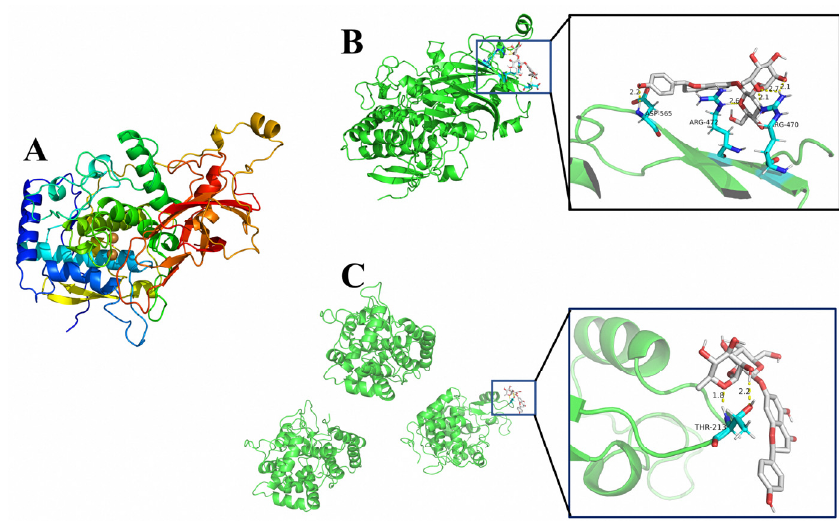
Figure 5. The 3D structure and molecular docking results. ( A ). The 3D crystal structure of PPO, ( B ) PPO and naringin docking results, ( C ) POD and naringin docking results.